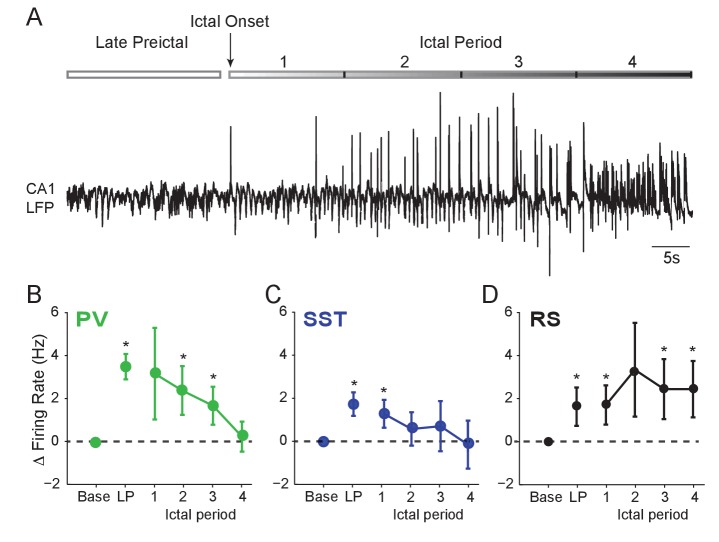
Interneuron firing rates decrease after ictal onset.(A) Upper: Schematic of experimental paradigm showing the late preictal (LP) period, ictal onset timepoint, and ictal period. Lower: LFP trace from hippocampal CA1 recording. (B) Mean changes in firing rate as compared to baseline during four ictal periods for PV interneurons (n = 9 cells in eight mice). Firing rate in fourth ictal period was significantly lower than in the LP period for PV cells. (C) Mean ictal changes in SST interneuron firing rate (n = 18 cells in 17 mice). (D) Mean ictal changes in RS cell firing rate (n = 16 cells in nine mice). Note, LP values are taken from the 4th preictal period shown in Figure 1. All statistical comparisons are to the baseline period. Error bars denote mean ±s.e.m. *p<0.0125, **p<0.0025.10.7554/eLife.40750.008Figure 2—source data 1.Figure 2 - Statistical results.